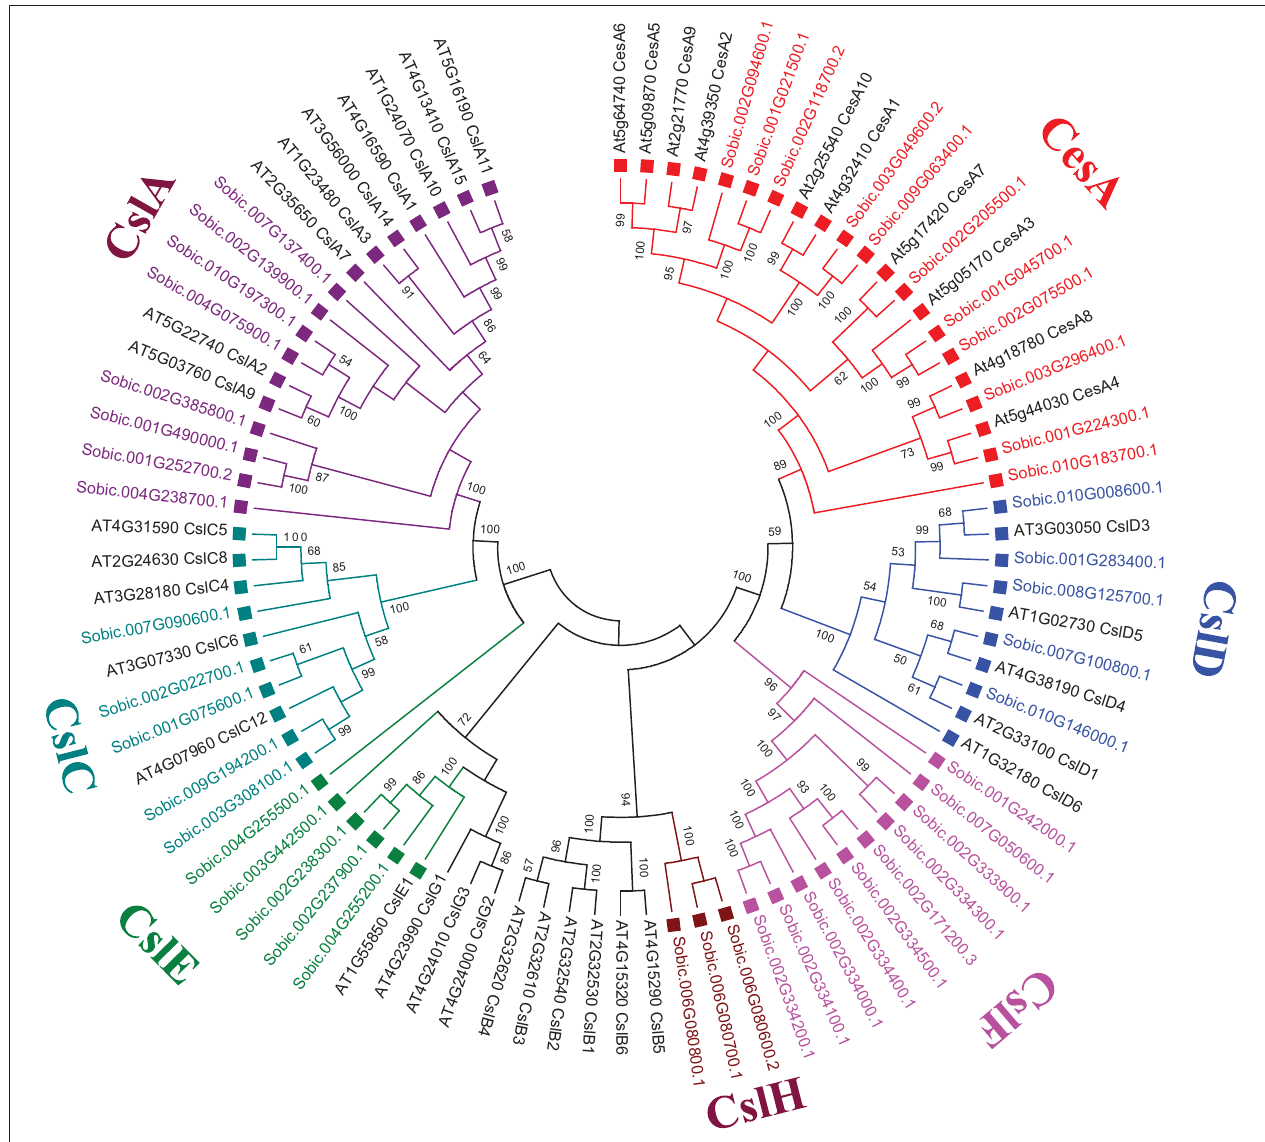
FIGURE 2 | Unrooted phylogenetic tree representing Cellulase synthase (CesA) and Cellulase synthase-like (Csl) gene family from S. bicolor and A. thaliana using MEGA6. Tree was constructed using Neighbor Joining method with 1000 times bootstrap value. Same colored blocks and text represents the genes from similar